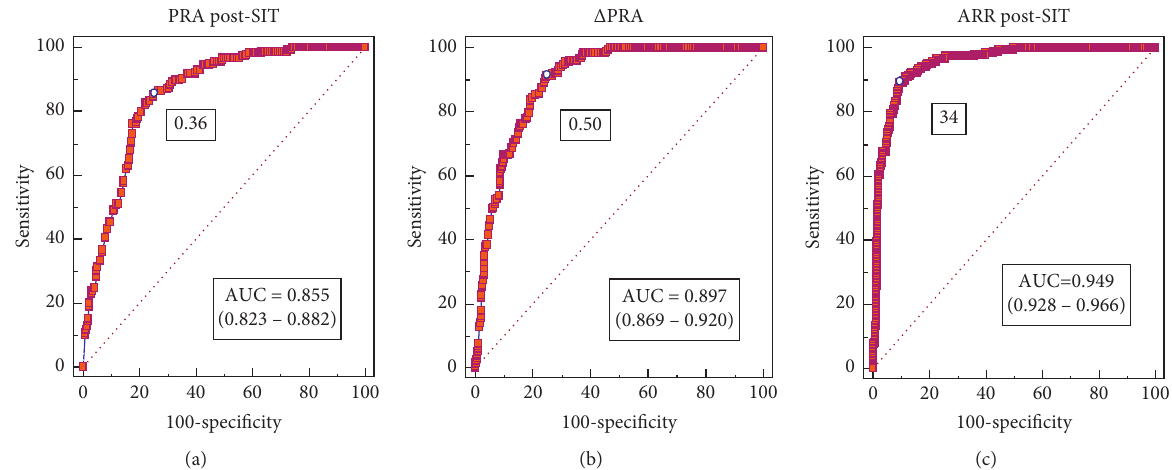
Figure 2: Receiver-operator characteristic (ROC) curves of PRA post-SIT, Δ PRA, and ARR post-SIT for primary aldosteronism (PA) diagnosis. PRA post-SIT (a), ROC curve of plasma renin activity after the saline infusion test; Δ PRA (b), ROC curve of reduction in PRA during the saline infusion test; and post-SIT ARR (c), ROC curve of aldosterone-renin ratio after the saline infusion test to diagnose PA. AUC indicates the area under the receiver-operator characteristics curve, and Δ PRA indicates reduction in PRA during SITand diagnostic accuracy of Δ PRA, PRA post-SIT, and ARR post-SIT for PA.